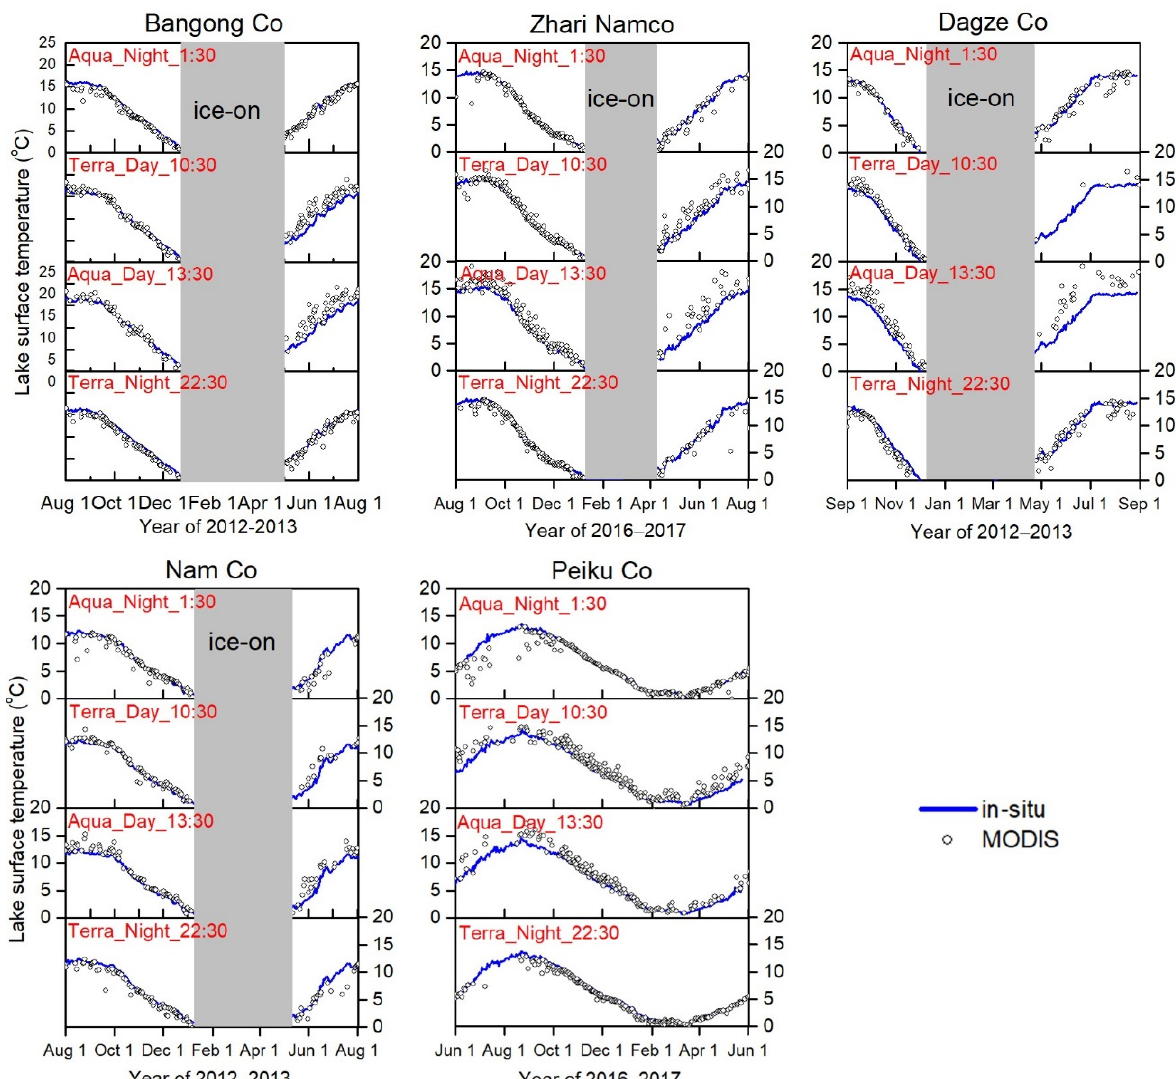
Figure 2. Comparison of daily MODIS-retrieved lake surface temperature and in-situ observed bulk temperature in the five large lakes. The four data layers for each lake represent daytime and nighttime for Terra and Aqua.